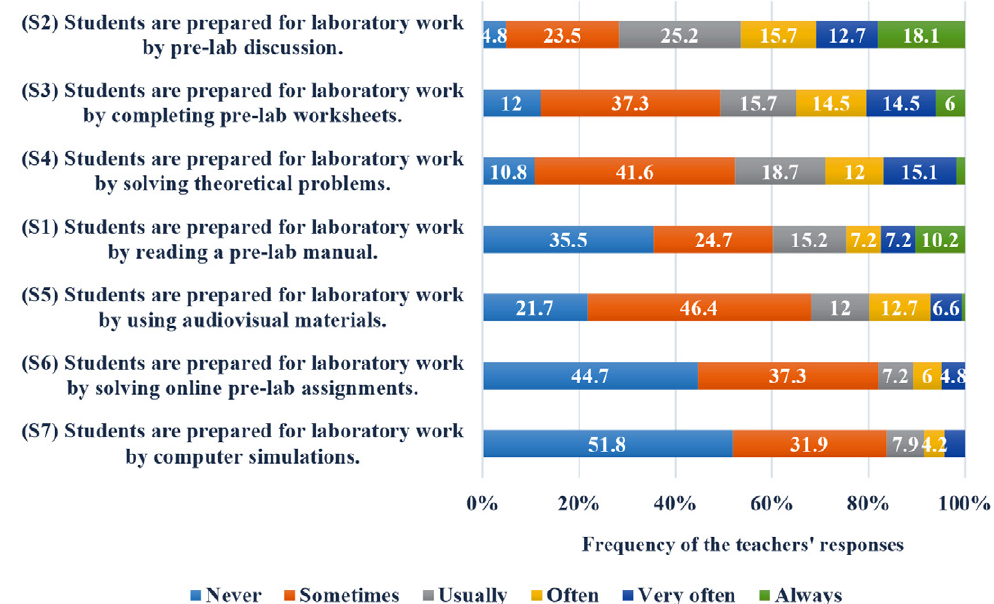
Figure 1: The frequency percentage of teachers’ responses (N=166) to the online survey of Using the Pre-Laboratory Activities, by statements